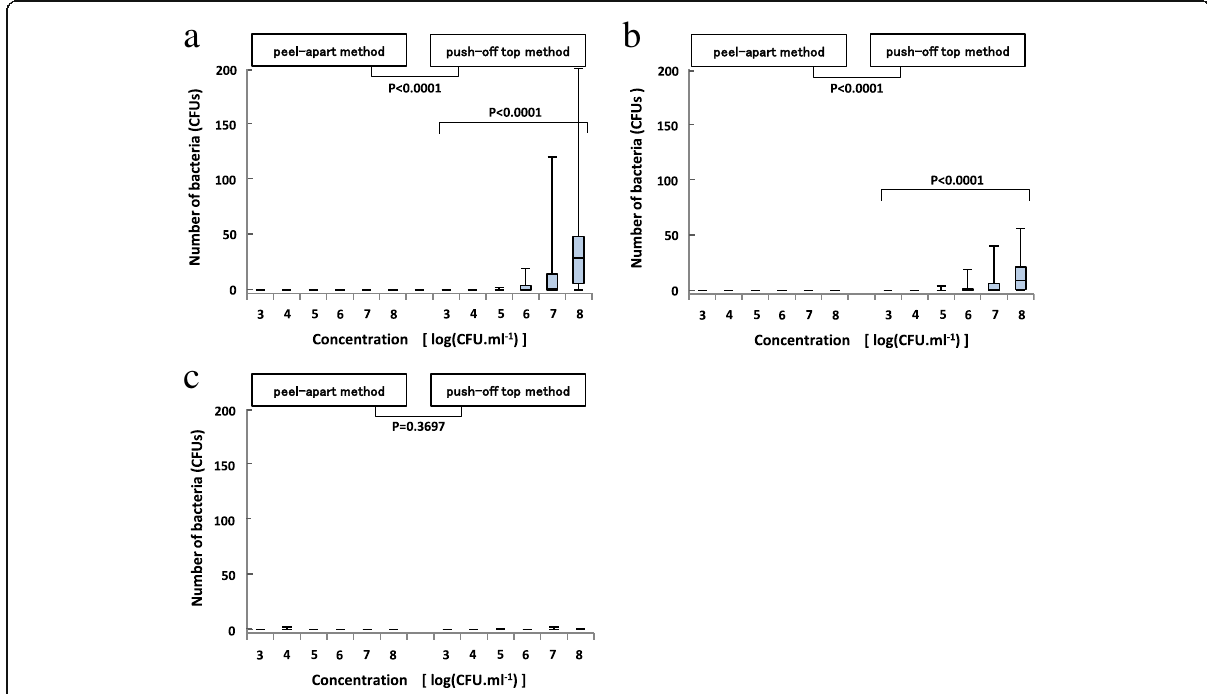
Fig. 3 a Contamination of the lateral surface of the needle hub. b Contamination of the bottom surface of the needle hub. c Contamination of the inner lumen of the needle hub. Regarding ( a ) and ( b ), the Cochran-Mantel-Haenszel test considering the concentration of S. aureus as a stratum was used to compare between opening methods. The Jonckheere test was performed to evaluate the concentration of the S. aureus -contamination relationship for the push-off top method data and was not performed for the peel-apart method because only one needle hub was contaminated.